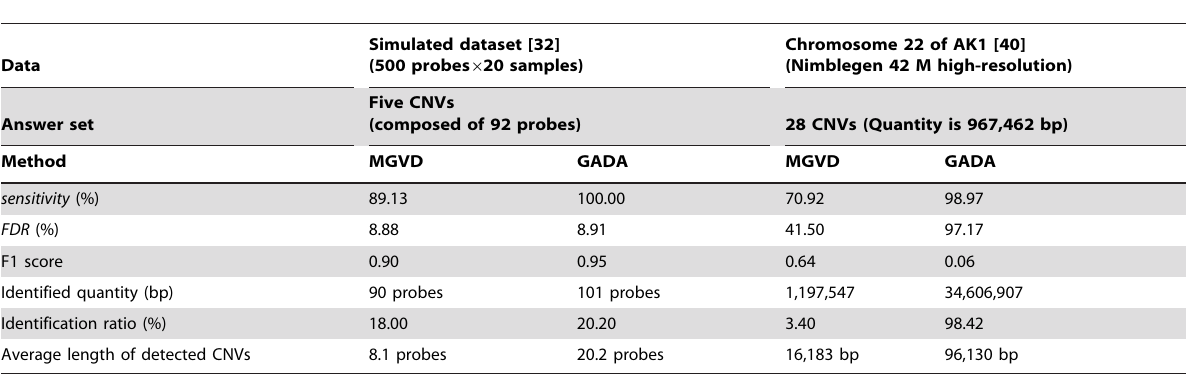
Table 2. The sensitivity and FDR dependence of the algorithms on the data